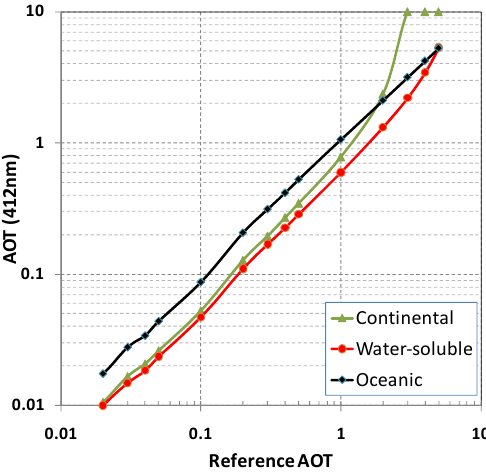
Fig. 21. Values of the AOT at λ = 550nm retrieved by the ART for different aerosol types from the simulated reflectance at the